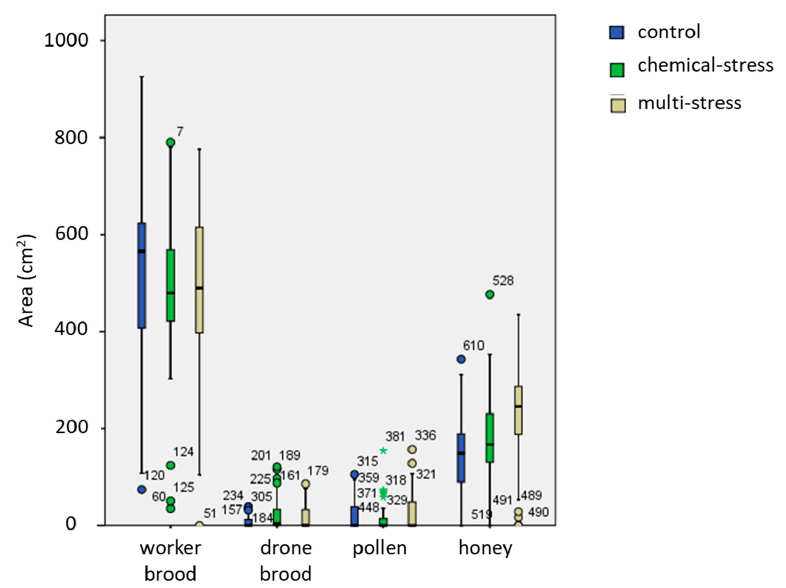
Figure 5. Box-plot chart of the area occupied by worker-brood, drone-brood, pollen and honey in the central honeycomb in the three experimental sites. Health status of the colonies was monitored also by collecting dead specimens in front of each hive (mortality in the underbaskets, Table 4). Mean number of dead worker bees were higher in treated sites in comparison to those in the control. Deformed worker bees, counted separately, were higher in the control site,due to the detection of a high level of infection with DWV in one hive of the control site. Drones and pupae were not different among sites, while the number of dead queens was higher in the multi-stress site. Queen and pupae (drones and worker bees) were detected rarely, and deformed drones were more frequent than deformed worker bees in relation to normal ones. Table 4. Mean number ± standard deviation (minimum-maximum interval in brackets) of dead specimens in 10 days found in the underbasket in control, chemical- and multi-stress sites. Treatment